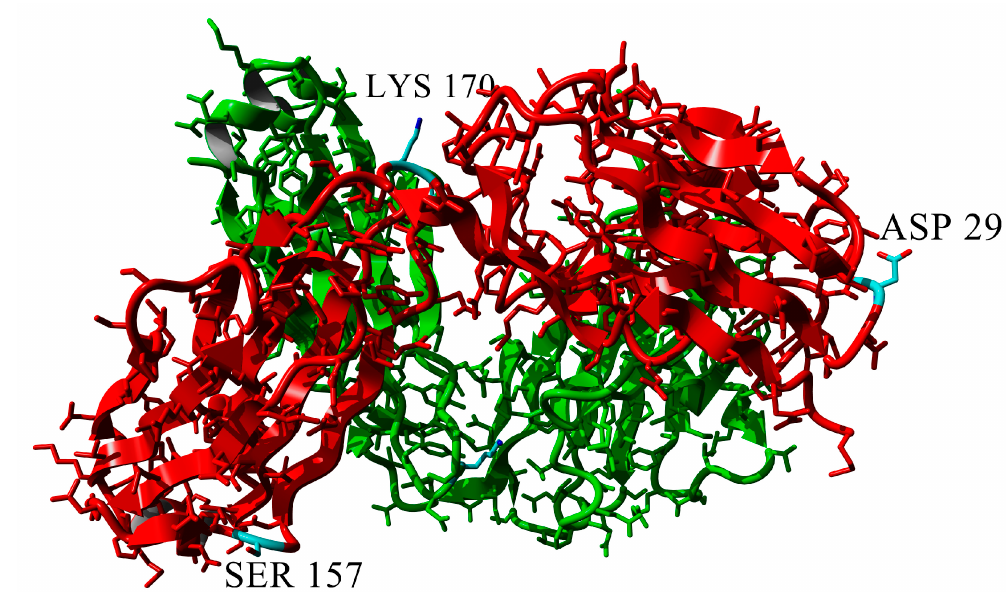
Figure 17. Location of three mutations affecting the kinetics of amyloidogenesis. Wild-type residues are shown, and they are labeled in one subunit of the dimer (top, red).